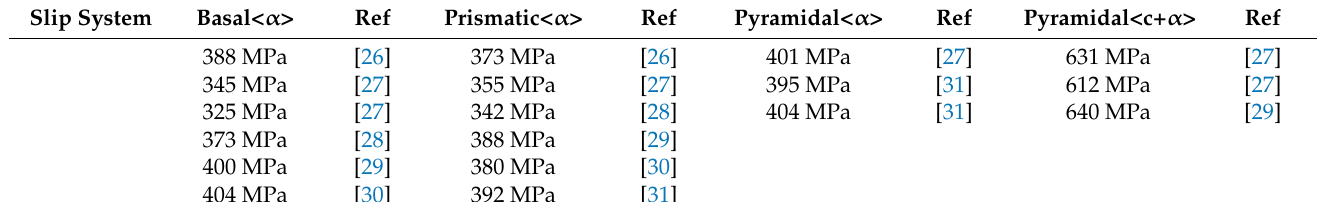
Table 4. The CRSS for different slip systems in α (cid:48) / α -grains at room temperature.